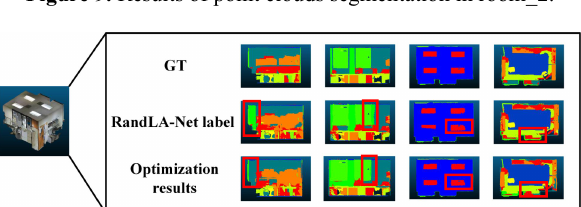
Figure 10. Results of point clouds segmentation in room_3.